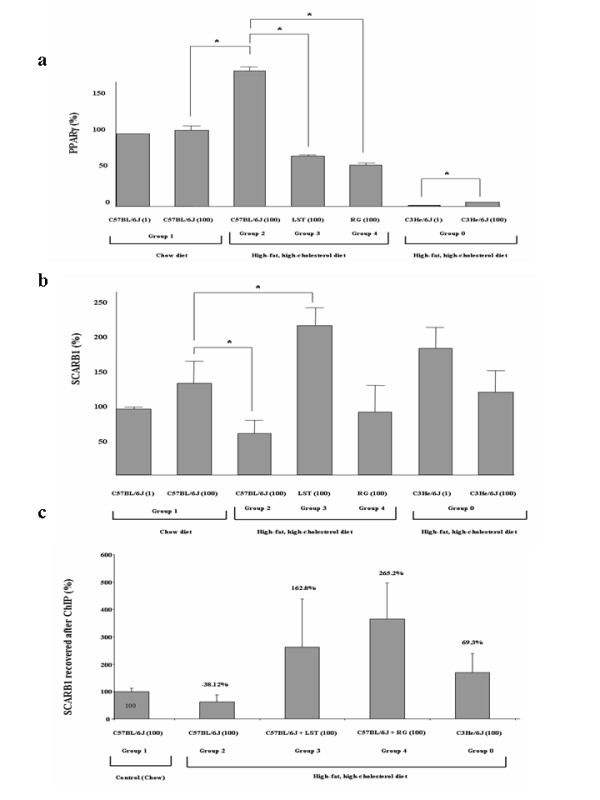
Treatments preserve PPARγ activity and PPARγ responsive gene expression. (a) PPARγ mRNA relative expression in pooled liver samples from analyzed groups normalized to GAPDH expression. Results are expressed as mean ± SEM percentage of mean values obtained from equal numbers of C57BL/6J and C3He/6J mice. *P < 0.05. (b). SCARB1 mRNA relative expression in liver samples from analyzed groups normalized to GAPDH expression. *P < 0.05 (c). ChIP with a PPARγ antibody of study groups was used to amplify a SCARB1 promoter fragment. ChIP figures percentages indicate increments or decrements regarding C57BL/6J mice fed HFHC diet. Data of C57BL/6J mice fed chow diet was established as 100%.